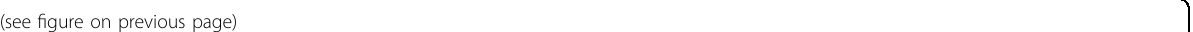
Fig. 6 The gut microbiota derived from the KO-DSS mice displayed more severe colon injuries in the FMT C57BL/6J mice. A Mice were administered with a spectrum antibiotic mixture of penicillin (200 U/mL) and streptomycin (200 μ g/mL) by oral gavage for 3 days and then transplanted with microbiota which were harvested from WT-DSS (WT-DSS FMT) and KO-DSS (KO-DSS FMT) mice for 5 days and rested for 3 days. Finally, 3% DSS was given to these mice and sacri fi ced in 7 days ( n = 5/group). B Body weight was recorded during FMT assay. C The length of the colon from WT-DSS FMT and KO-DSS FMT mice was recorded after 7 days of 3% DSS treatment. D Representative images of PAS staining of the colon tissue and statistical analysis of the PAS-positive cells number. Black arrows pointed to the PAS-positive cells. Scale bars: 200 μ m (whole colon sections) and 50 μ m (enlarged insets). E The expression of ZO1, MUC1, and occludin in the colon of WT-DSS FMT and KO-DSS FMT mice were detected by western blotting. F Quali fi cation of the band intensity of occludin, MUC1, and ZO-1. G q-PCR analyzed the mRNA expression level of antimicrobial peptides such as Defa-1 , Defa-4 , Defa-5 , Camp , and Lyz in colon tissue. H q-PCR analyzed the mRNA expression level of Il-1 β , Il-6 , Il-22 , Il-23 , Ifn- γ , and Tnf- α in colon tissue. I Fecal microbiota from WT-DSS and KO-DSS mice co-cultured with intestinal epithelial cell line MODE-K. J ROS levels of MODE-K cells treated with microbiota were detected by fl uorescent probe (red). The black arrows were directed toward the ROS-positive cells. Scale bars: 50 μ m. K q-PCR analyzed the mRNA expression of occludin , Muc1 , Muc2 after MODE-K cells were infected with fecal microbiota. L q-PCR analyzed the mRNA expression of Il-1 β , Il-6 , Il-10 , and Tnf- α in MODE-K infected with fecal microbiota. All bars represent the mean of measurements from three independent experiments, and the error bars indicate ±SEM; * P < 0.05, ** P < 0.01, *** P < 0.001, “ ns ” indicates not signi fi cant. Two-tailed Student ’ s t test ( B – H , J – L